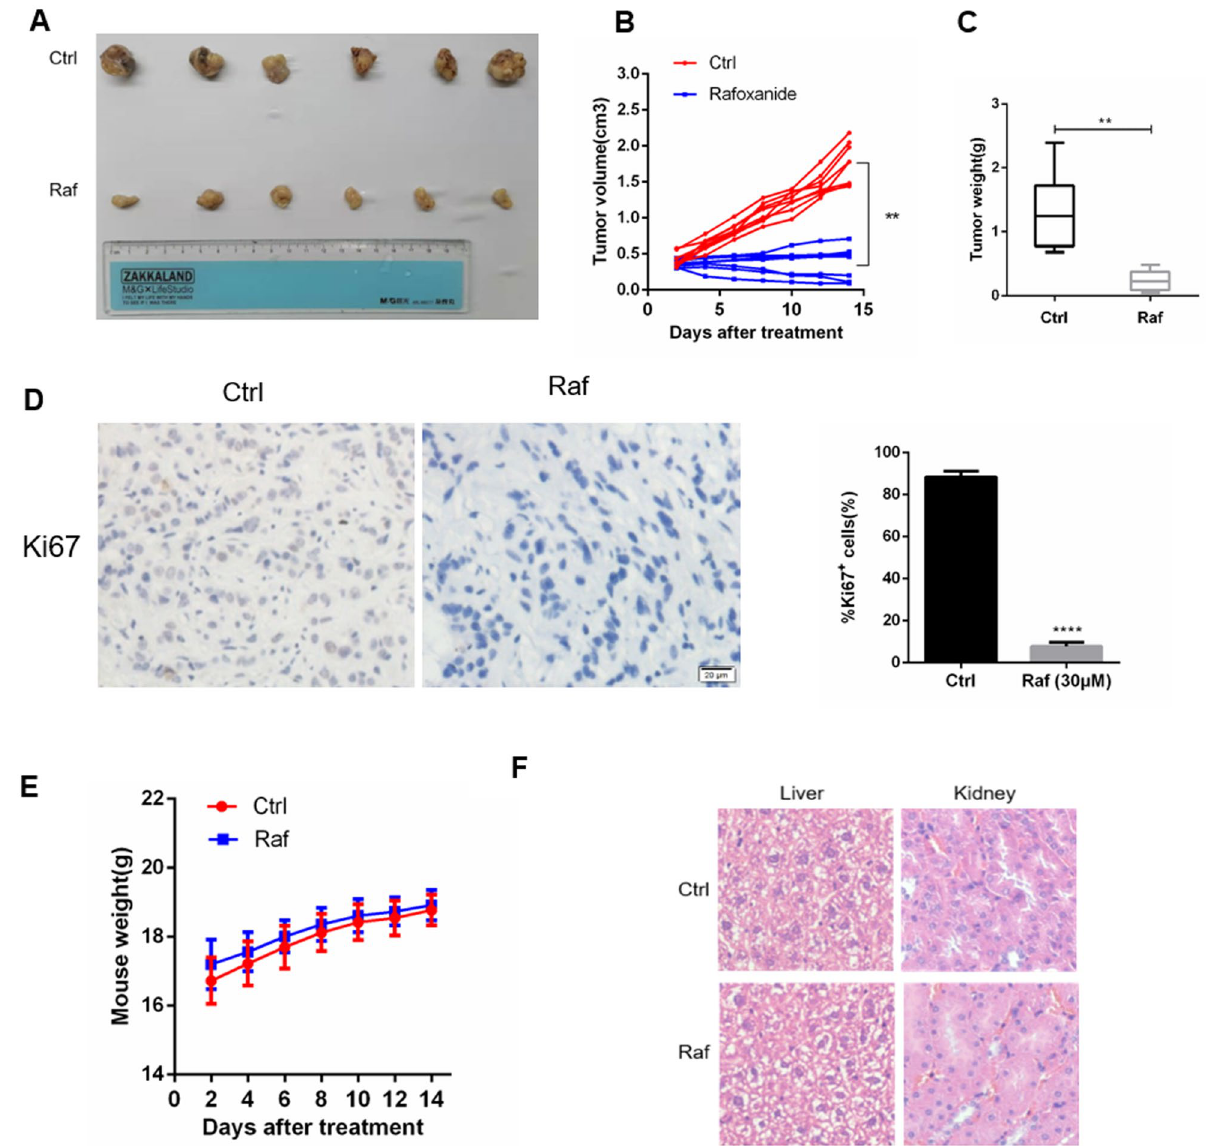
Figure 7. Rafoxanide exhibited anti-tumor activity in vivo. A549 cells were injected into BALB/c nude mice and when the tumor grew to 100 mm 3 , the mice were treated once a day with 15 mg/kg rafoxanide or vehicle . (A–C ) Tumor volume was measured. 14 days later, the tumor samples were collected, photographed, and weighted. ( D ) Tumor tissues were stained with anti-Ki67. ( E ) Mice were weighted during therapy . ( F ) Histopathological analysis of major organs by H&E staining from the control and rafoxanide treatment groups. Data are expressed as mean ± SD of three experiments. * P < 0.05, ** P < 0.01, *** P < 0.001, **** P < 0.0001.